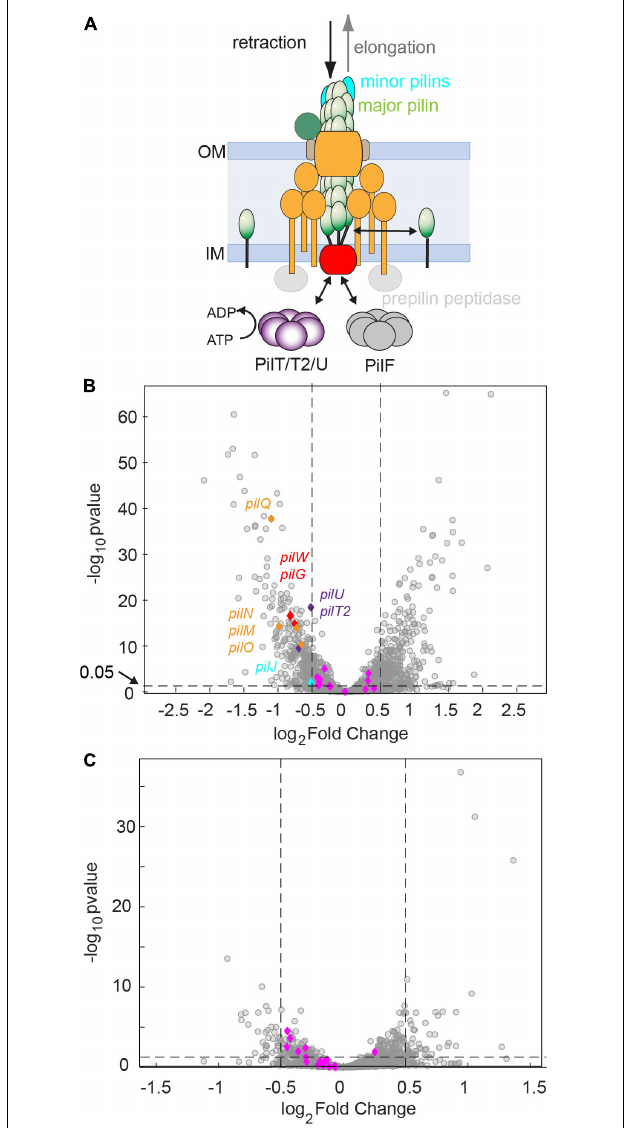
FIGURE 4 | Genes required for assembling the T4P core complex are downregulated after 60 min of antibiotic treatment at twofold MIC. (A) Sketch of the T4P assembly complex including the pilus fiber and the elongation and retraction ATPases. (B,C) Volcano plots showing adjusted p -values as a function of the log 2 fold changes of RNA levels relative to the DMSO-untreated control determined by RNA sequencing. Gray: all genes. Blue and other colors: genes involved in T4P assembly. Dotted lines: Genes are defined to be differentially regulated if adj. p ≤ 0.05 and (cid:12) (cid:12) log 2 fold change (cid:12) (cid:12) ≤ 0 . 5. (B) Treatment with azithromycin. 12.9% of genes are downregulated. 14.3% of genes are upregulated. (C) Treatment with ceftriaxone. 1.6% of genes are downregulated. 2.6% of genes are